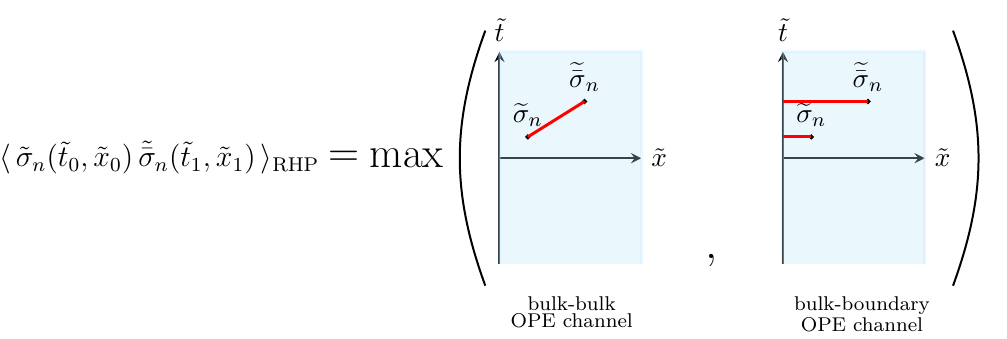
Figure 6 . The bulk-bulk OPE channel and the bulk-boundary OPE channel contributing to the two-point function of twist operators in two-dimensional holographic BCFT. A channel with larger value is favored, and there can be a phase transition between the